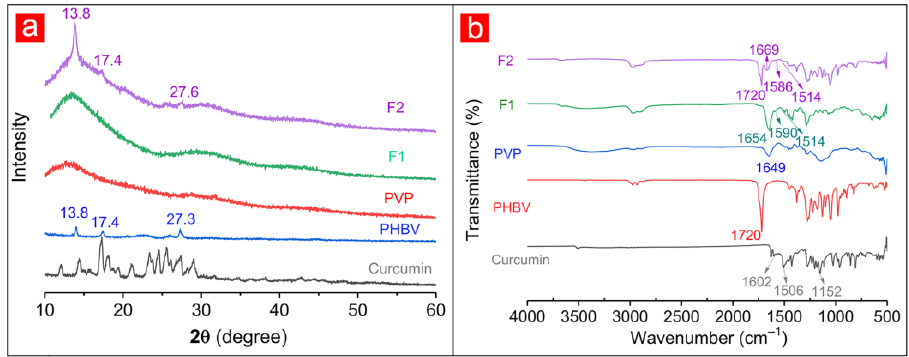
Figure 3. XRD patterns ( a ) and ATR-FTIR spectra ( b ) of raw materials (i.e., PVP, PHBV, and Cur) and fibers (i.e., F1 and F2).